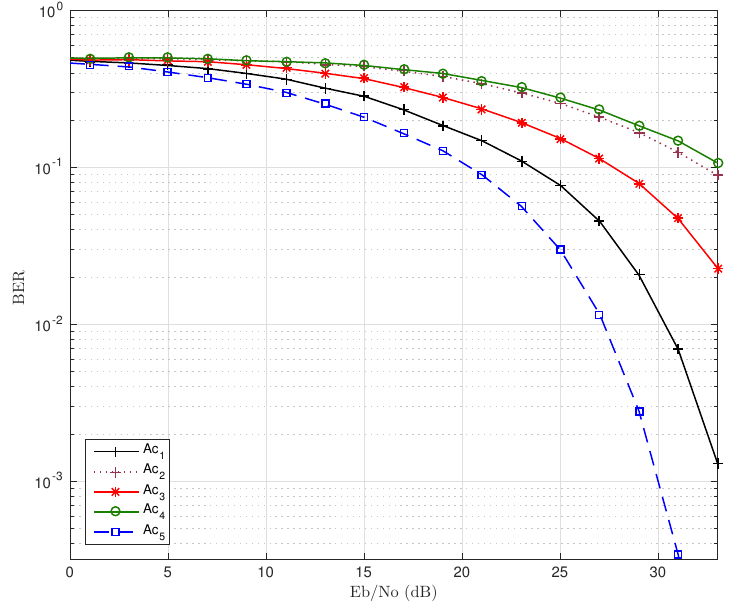
Figure 13. BER vs. Eb/N0 comparison of the proposed SC-FDM communication system among each of the couplings with N p = 16, FFT = 256, 64 QAM and BW = 200